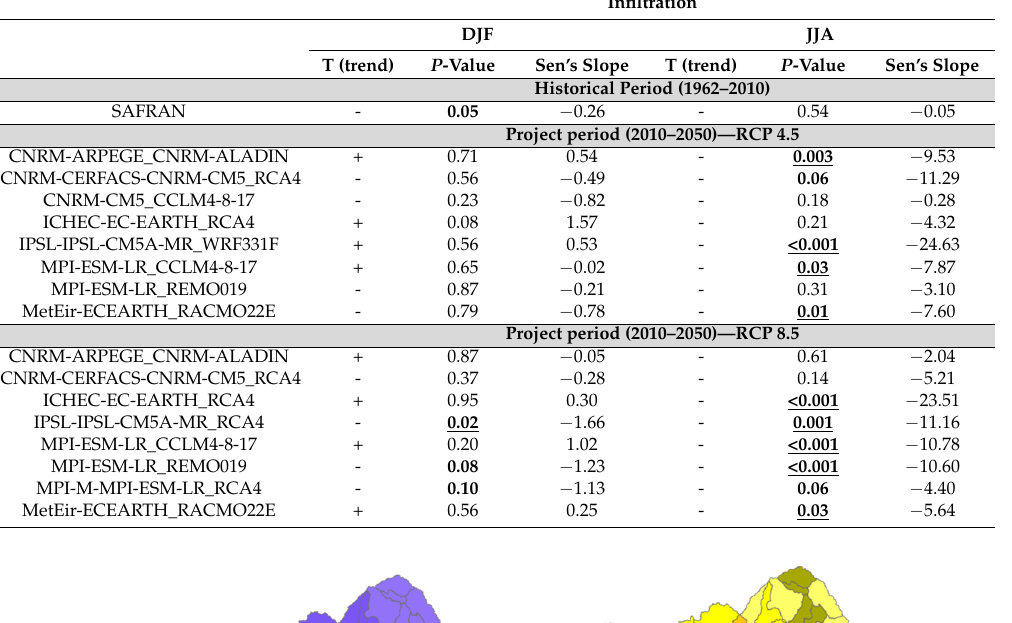
Table 9. Trend in infiltration over winter (DJF) and summer (JJA) seasons at watershed scale, for SAFRAN (historical period) and climatic ensemble (projected period). Bold numbers are significant trend considering α = 0.1 and underlined numbers considering α = 0.05.